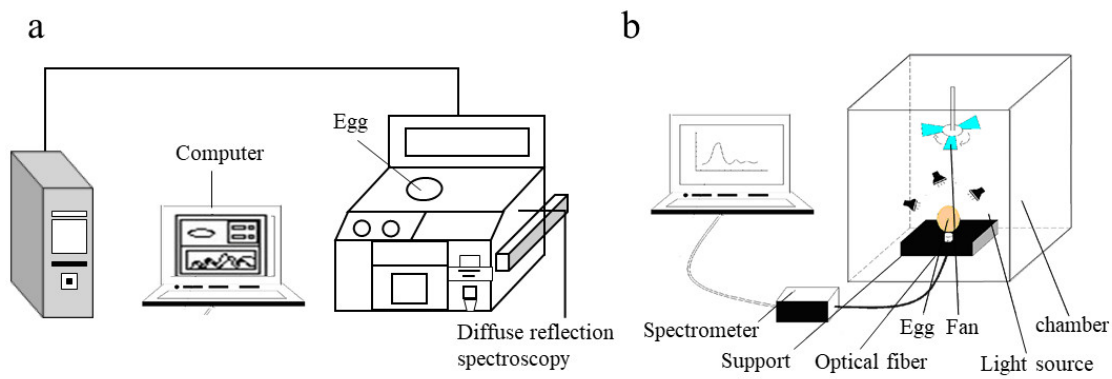
Figure 1. A schematic diagram for NIR spectra collection device using diffuse reflectance mode ( a ) and diffuse transmittance mode ( b ).